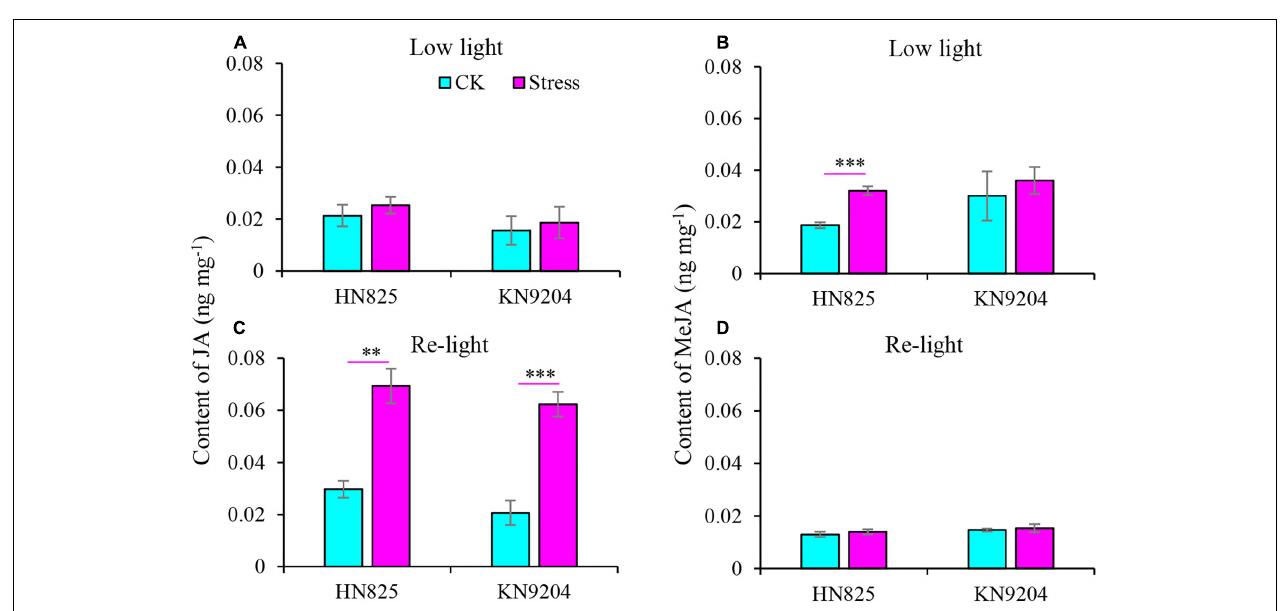
FIGURE 5 | Effect of low light on the contents of jasmonic acid (JA) (A,C) and methyl-jasmonate (MeJA) (B,D) in the spikelet of two wheat cultivars (‘HN825’ and ‘KN9204’). Low light, under low light stress; Re-light, early grain filling stage (20 days after low light treatment). Significant differences between the CK and stress treatments are indicated by asterisks ( ∗∗ P < 0.01; ∗∗∗ P < 0.001, Student’s t -test).